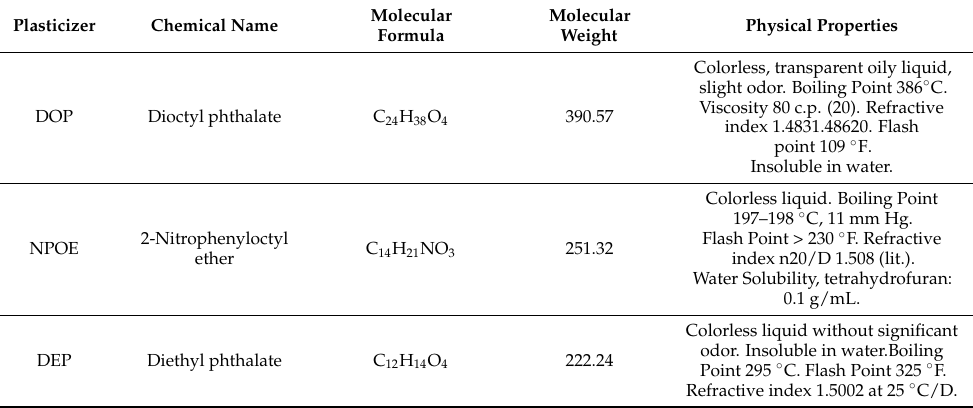
Table 1. Detailed characteristic information of DOP, NPOE, and DEP as the membrane